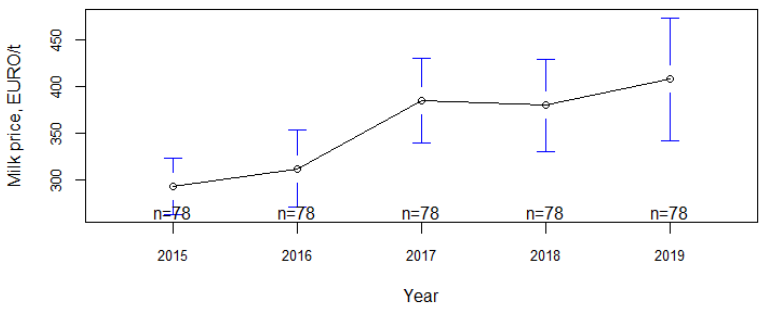
Figure 3. Mean raw milk prices in Russia